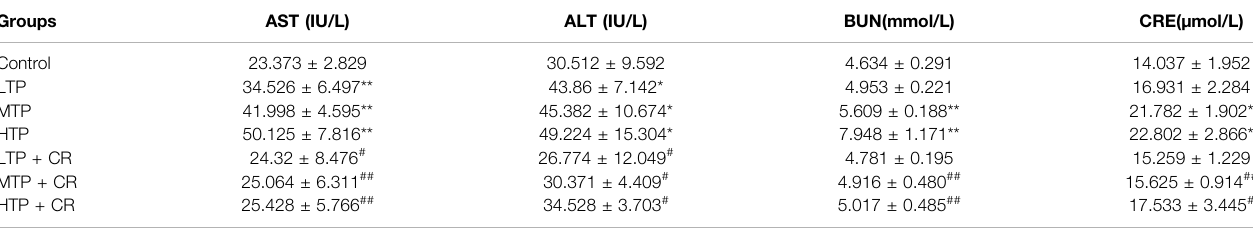
TABLE 3 | Comparison of hepatic and renal functions among the groups of mice ( (cid:1) x ± S, n = 6). Groups